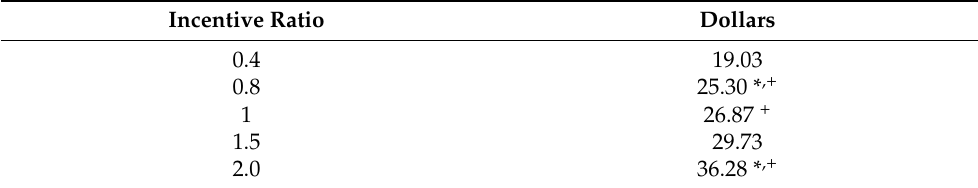
Table 3. SNAP expenditures at farmers’ markets, per transaction and by incentive level.